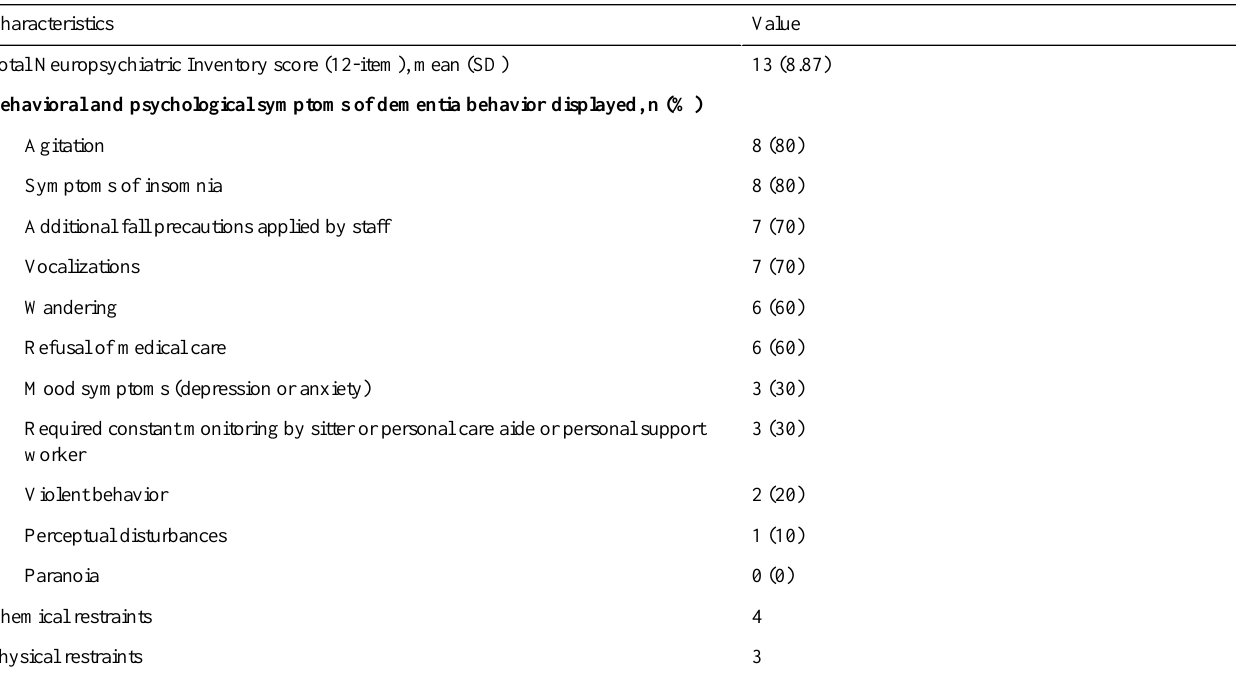
Table 1. Behavioral and psychological symptoms of dementia at baseline and in-hospital (N=10). ValueCharacteristics